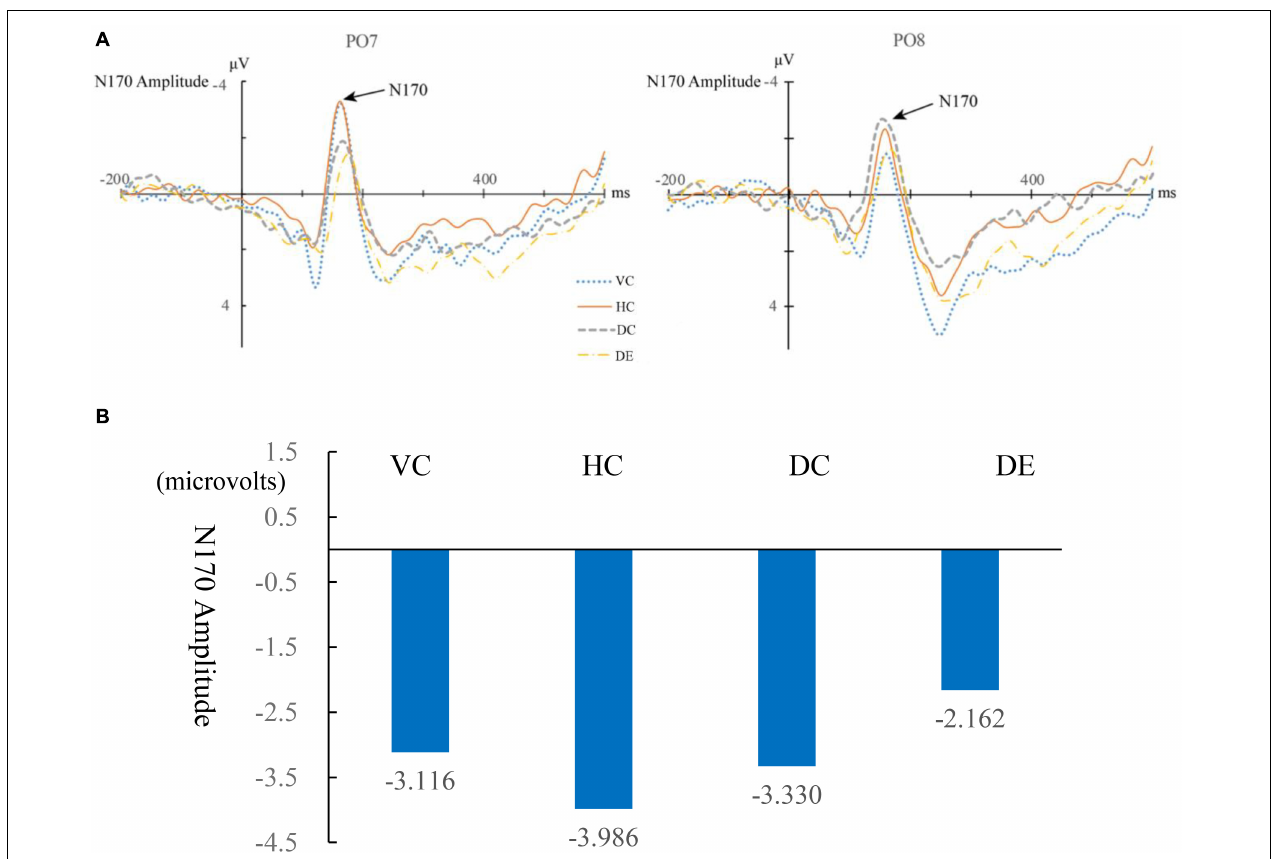
FIGURE 4 | (A) Event-related potential (ERP) waveforms of N170 under four conditions for adults for the left (PO7) and right (PO8) parietal leads. VC, viewing Chinese; HC, handwriting Chinese; DC, drawing followed by Chinese recognition; DE, drawing followed by English recognition. (B) Differences between the four conditions for adults in the amplitude of N170.